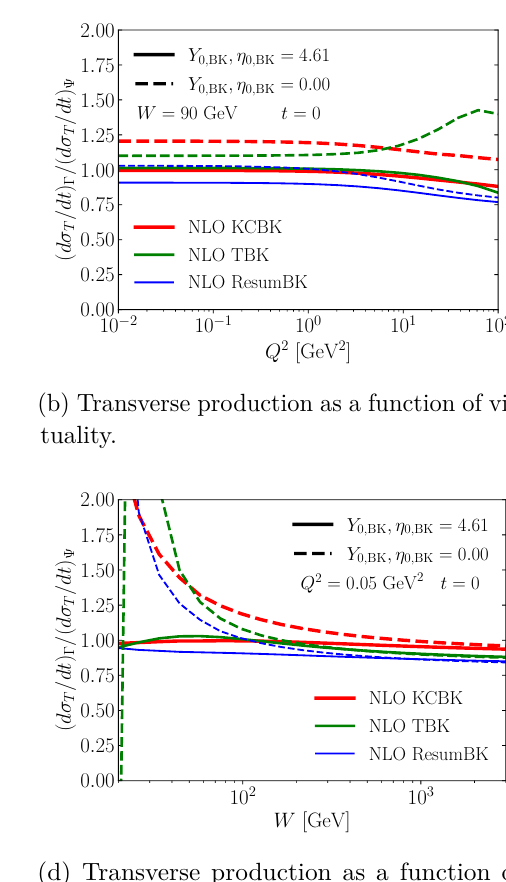
center-of-mass energy. Figure 7. Scheme dependence of the differential J /ψ production cross section at NLO illustrated as a ratio of the cross sections calculated in the decay width ( Γ ) and wave function ( Ψ ) schemes in the nonrelativistic